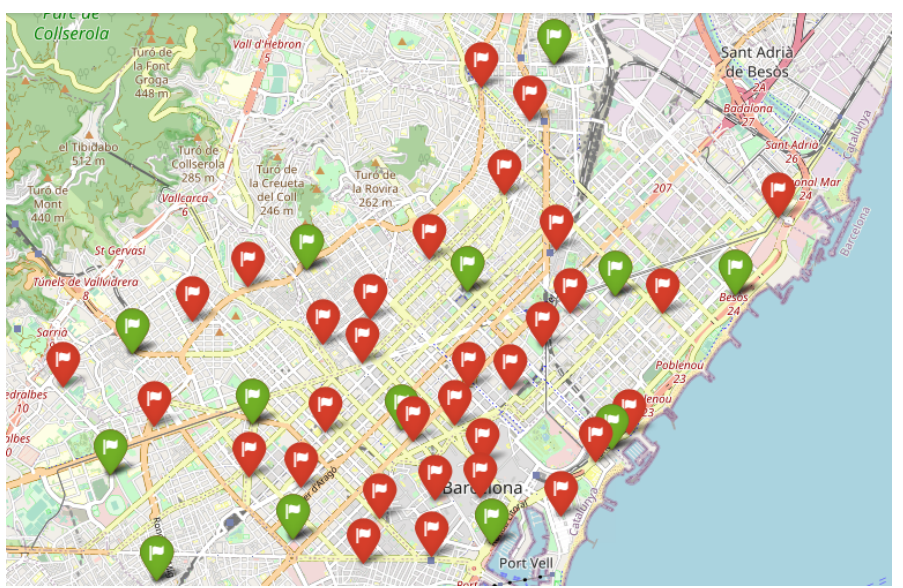
Figure 9. Fluid, 13 Selected